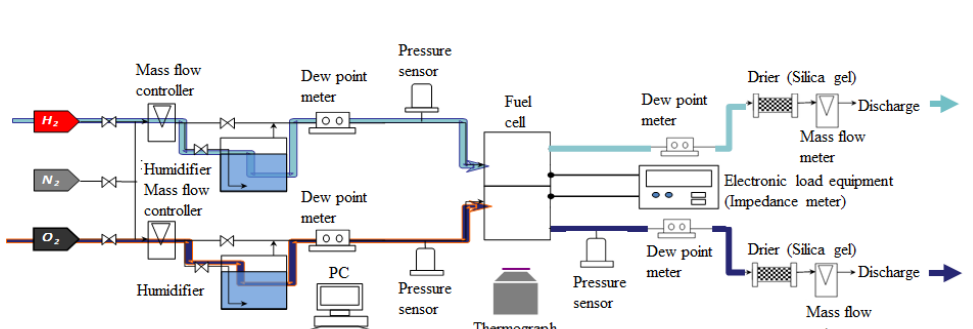
Figure 2. Schematic drawing of the experimental setup. The flow rates of supply gases were controlled using a mass flow controller. The load current of a single PEMFC was controlled via the electronic load equipment.